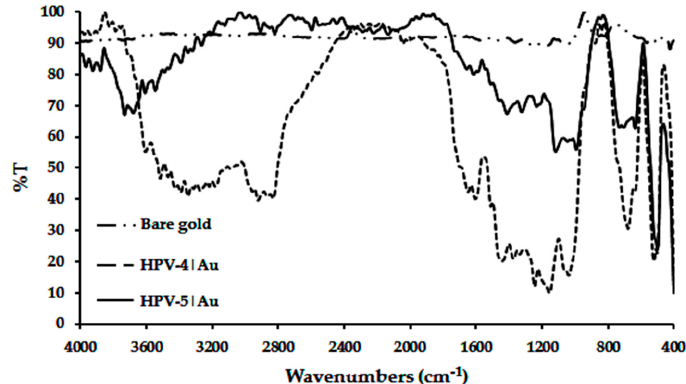
Figure 4. FT-IR spectrum of HPV-4 | Au, HPV-5 | Au and bare Au electrodes at an incident ray angle of 60°.